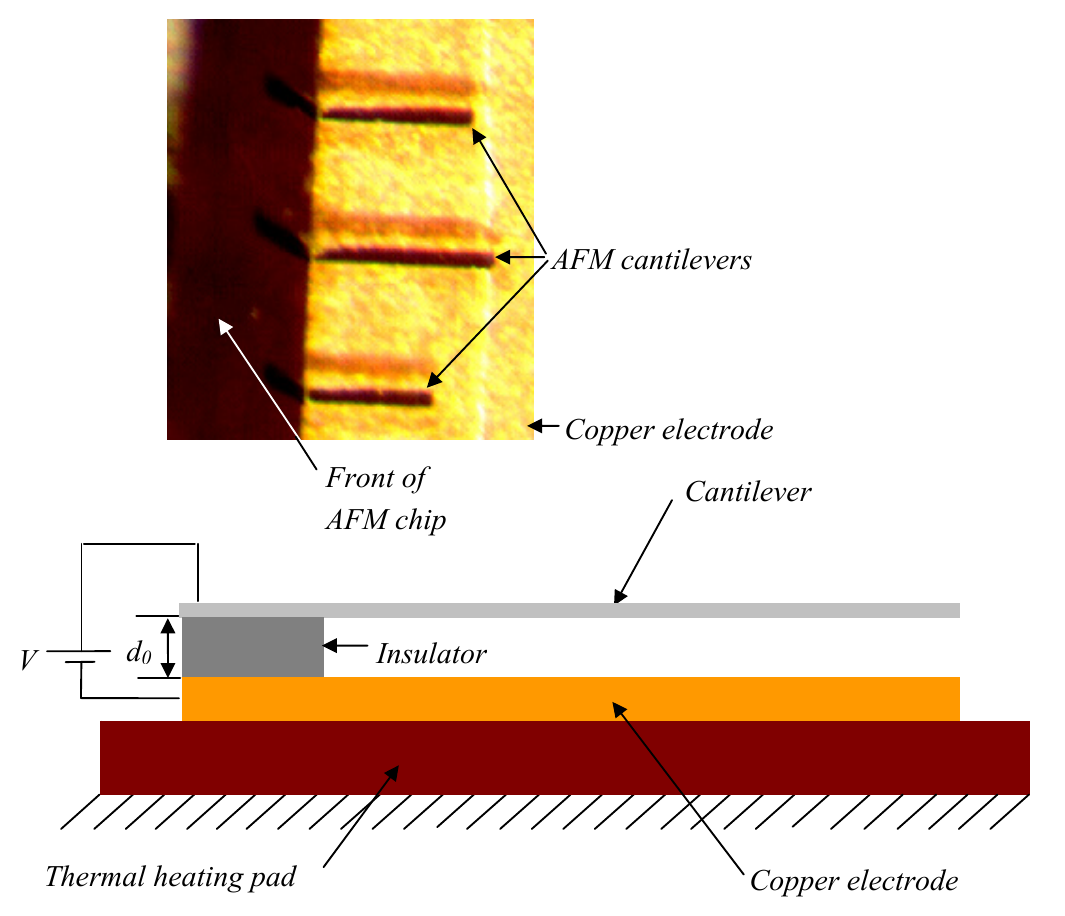
Figure 9. Top: Microscope image of an AFM chip and three AFM cantilevers. Bottom: Schematic side view of a cantilever in an applied electro-thermal environment as carried out in this